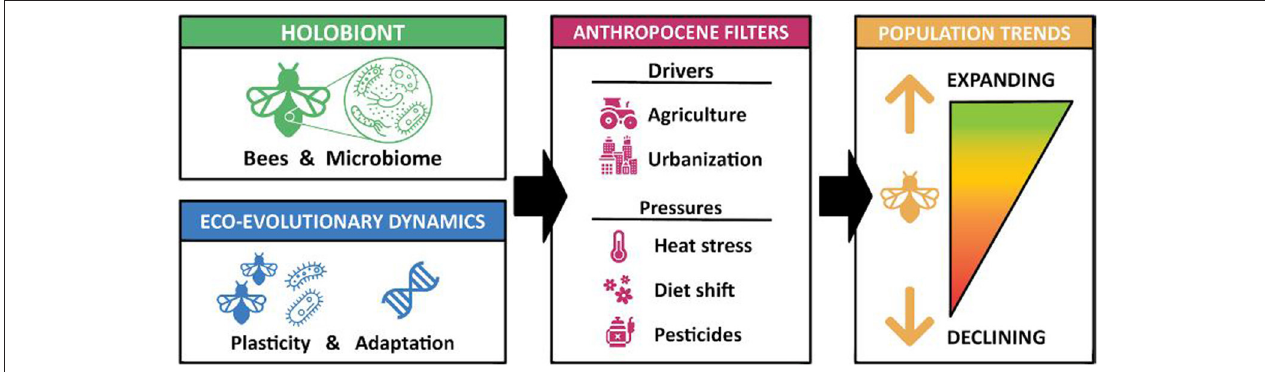
FIGURE 1 | Conceptual diagram showing both holobiont partners with their different eco-evolutionary dynamics, and who together can have a greater chance to pass through the ongoing pressures of Anthropocene filters, which may better explain the observed bee population